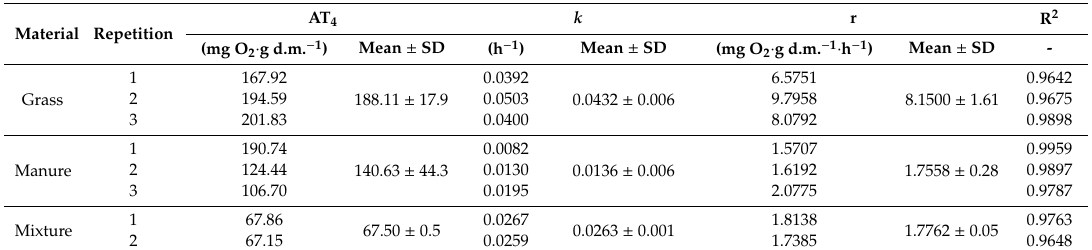
Table 1. The kinetic parameters of respiration activity for grass, manure, and biowaste mixture (shown in Figure